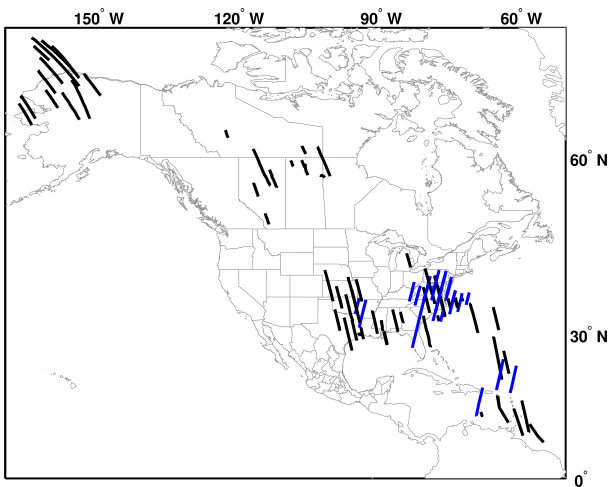
Figure 1. Flight track map of all HSRL coincident underflights of CALIPSO in this study. Black lines represent daytime measure- ments and blue lines represent nighttime (updated from Rogers et al.,